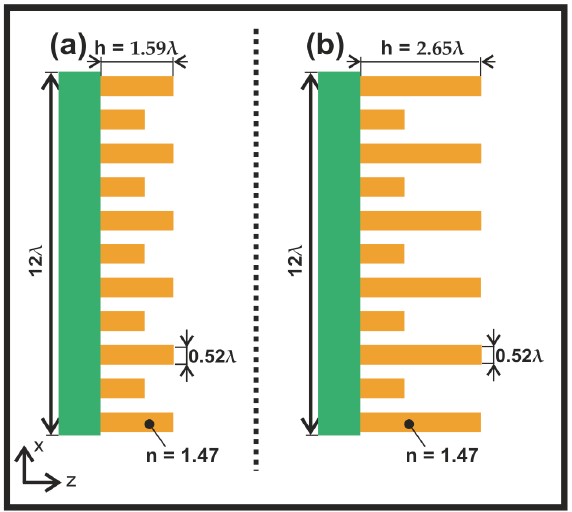
Figure 5. Cross sections of the studied 3D microstructures with a GRIN substrate at h 2 = ( a ) 1.59 λ and ( b ) 2.65 λ .